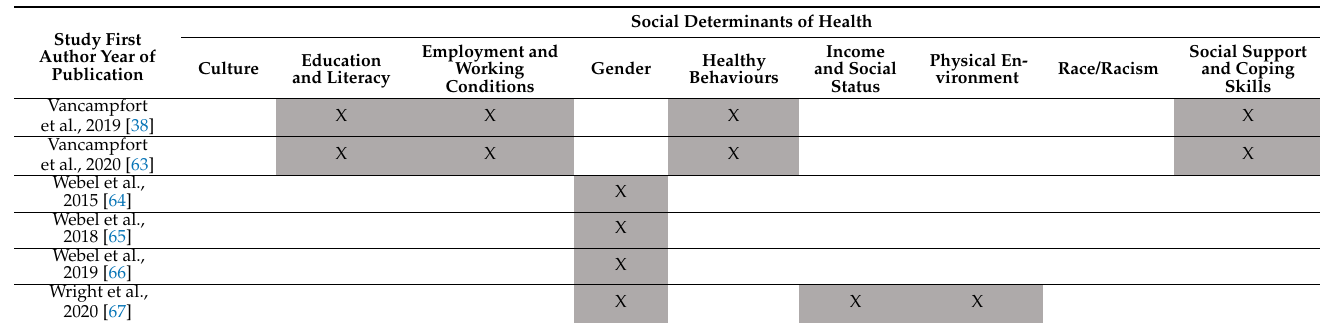
Legend: ‘X’ and grey shaded cell indicates SDOH was represented in the